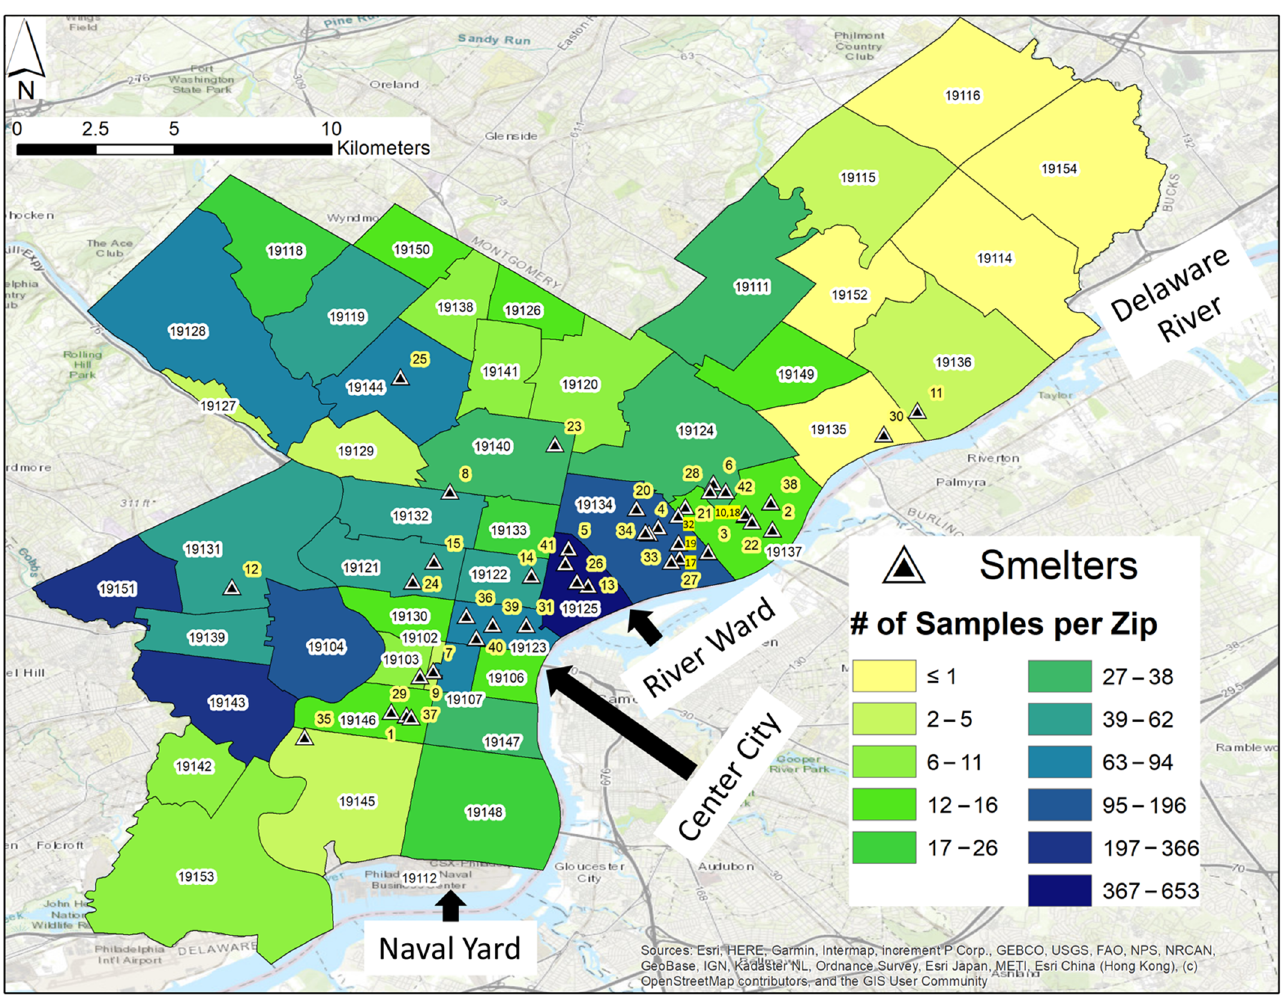
Figure 2. Map of Philadelphia, separated by ZIP codes. The color of each ZIP-code area corresponds to the number of soil sample points. Former smelter/processor sites are referred to above as “Smelters” for simplicity and are labeled as black triangles with white edges and numbered, with numbers highlighted with a yellow halo. Note, sites 10 and 18 overlap and are represented by one triangle. See Table S1a,b for sample site coordinates and view Table S2 for smelter/processor site details. Key points of interest are labeled on the map.